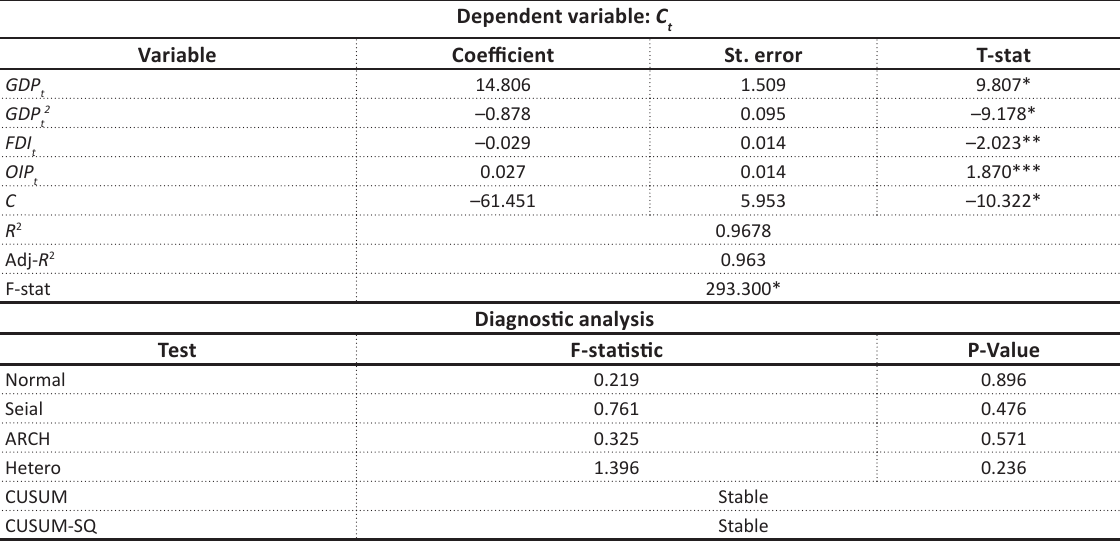
Table 3. Linear ARDL model long-run